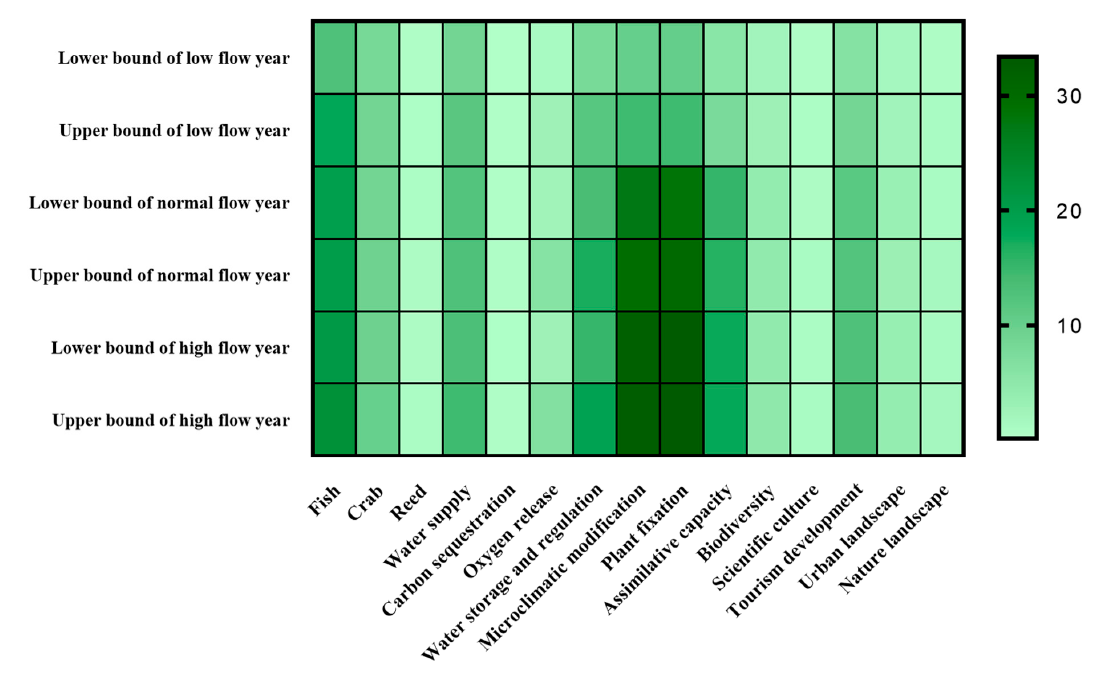
Table 3. Interval value of the ecological service values of different functional areas.